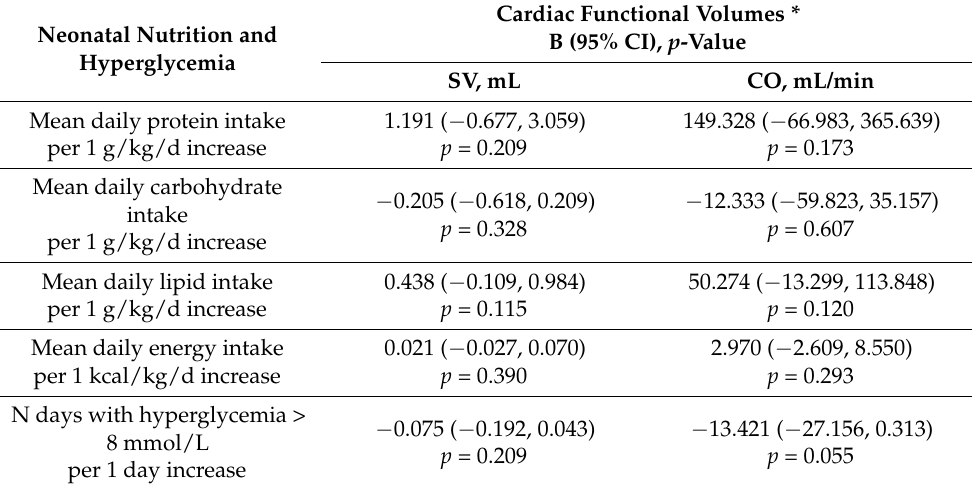
Table 5. Associations between macronutrient and energy intakes and hyperglycemia during the neonatal period with cardiac functional volumes at 6.5 years of age in children born extremely preterm.